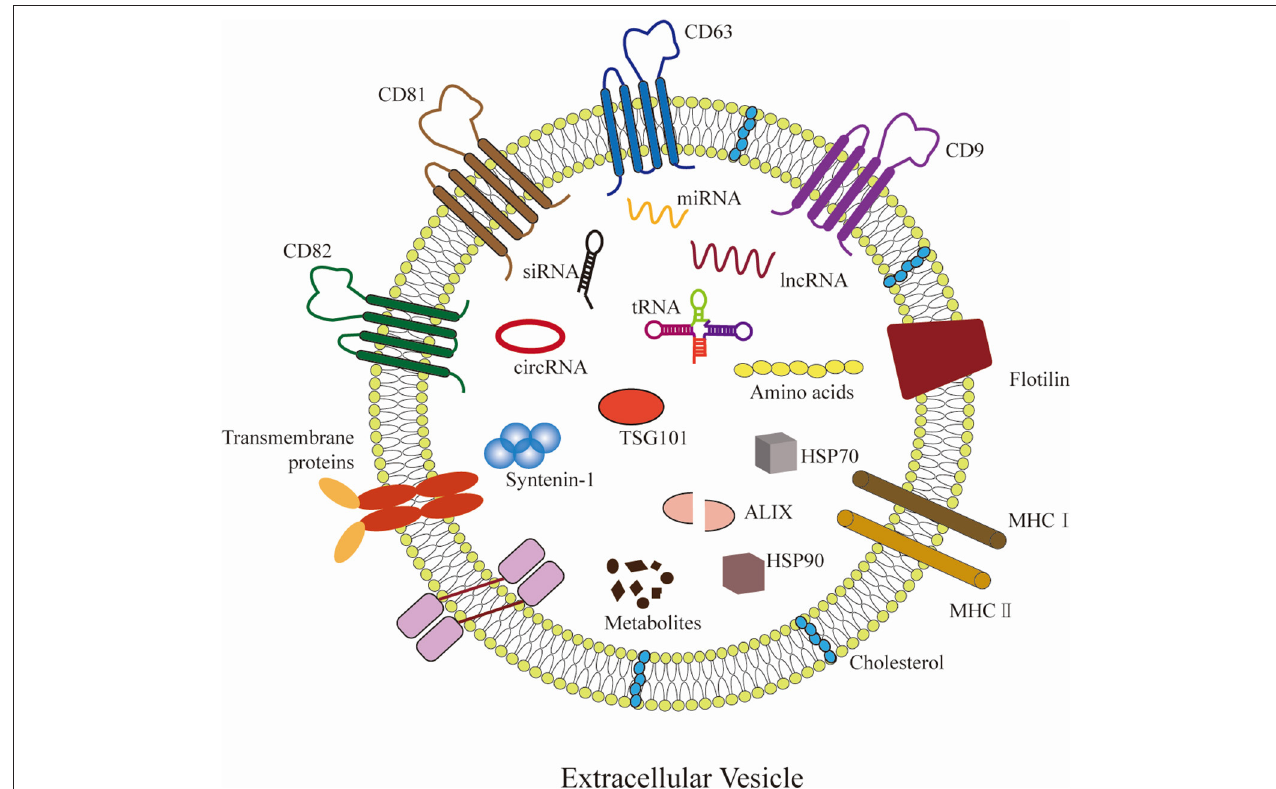
FIGURE 1 | Hallmarks of EVs. EVs can be secreted by almost all cells. EVs carry various molecular cargos, including proteins, lipids, metabolites, and nucleic acids (mRNAs, miRNAs, lncRNAs, etc.). Proteins include tetraspanins (CD9, CD63, CD81, and CD82), ESCRT proteins (such as ALIX and TSG101), and syntenin-1